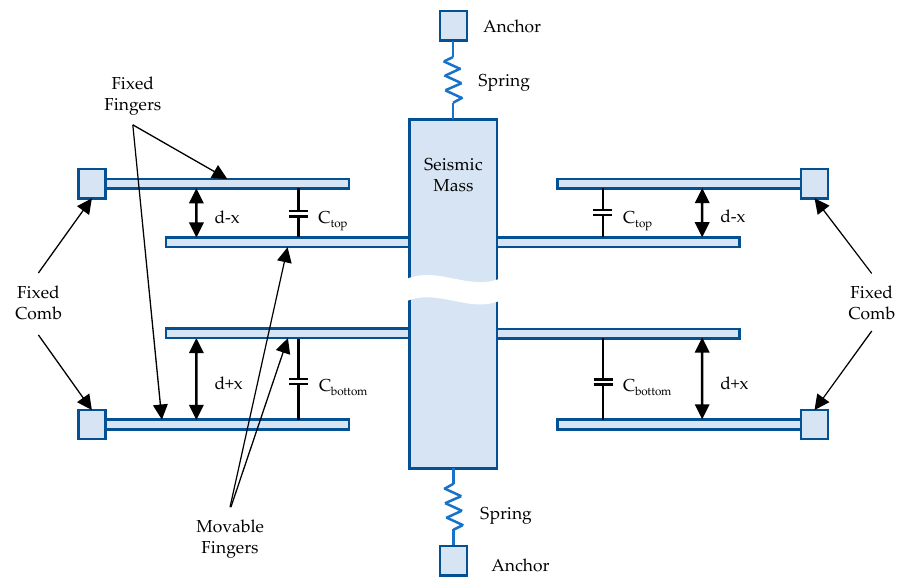
Figure 1. The operation principle of the capacitive accelerometer acting in the X and Y axes (not to scale).